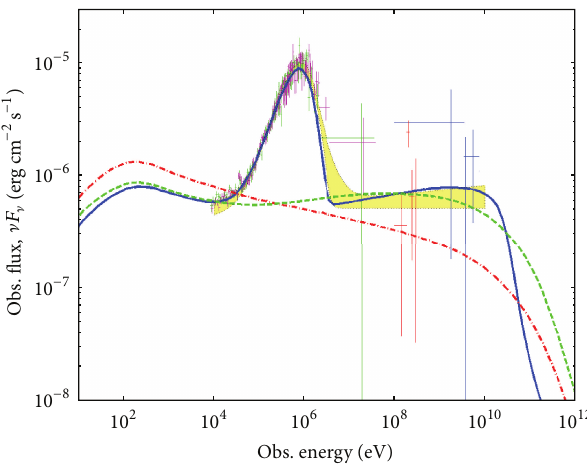
Figure 18: Spectral decomposition of GRB090902B (taken at time interval ( 𝑐 ), 9.6–13.0 seconds after the GBM trigger) enables clear identification of the physical origin of the emission. The dash-dotted (red) curve shows the spectrum that would have been obtained if synchrotron radiation was the only source of emission. The dashed (green) curve shows the resulting spectrum from synchrotron and SSC, and the solid (blue) curve shows the spectrum with the full radiative ingredients (synchrotron, SSC, the ∼ MeV thermal peak, and Comptonization of the thermal photons). Numerical fits are done using the radiative code developed by Pe’er and Waxman [428]. Figure is taken from Pe’er et al.